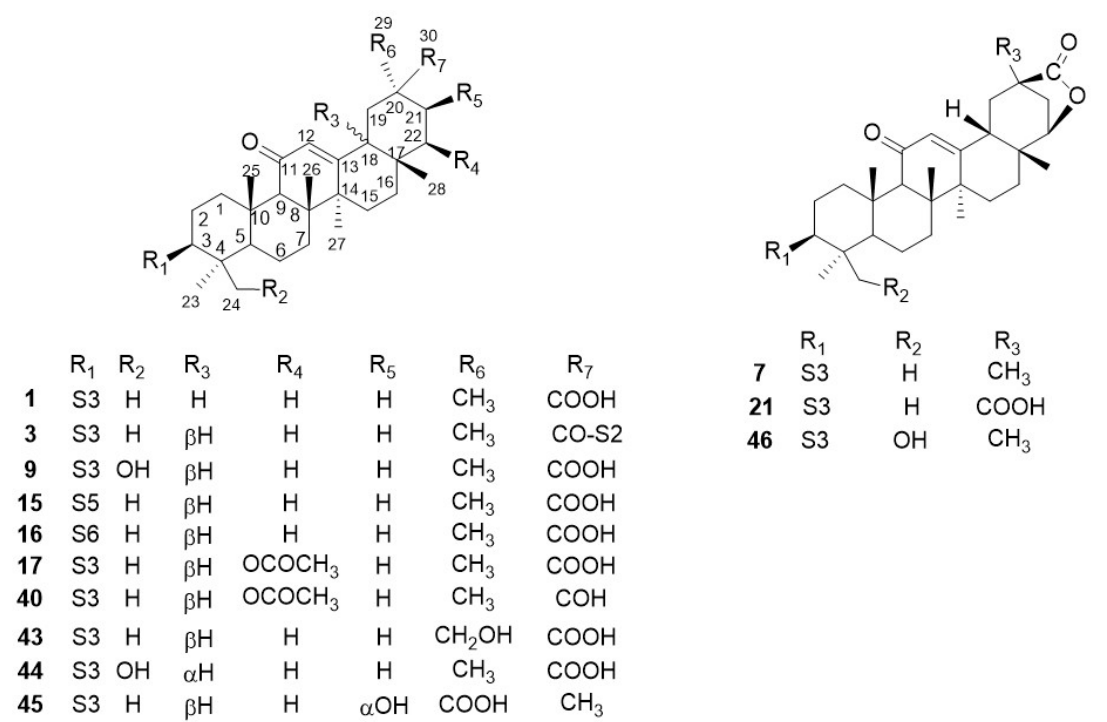
Figure 3. Triterpene saponins in G. inflata.